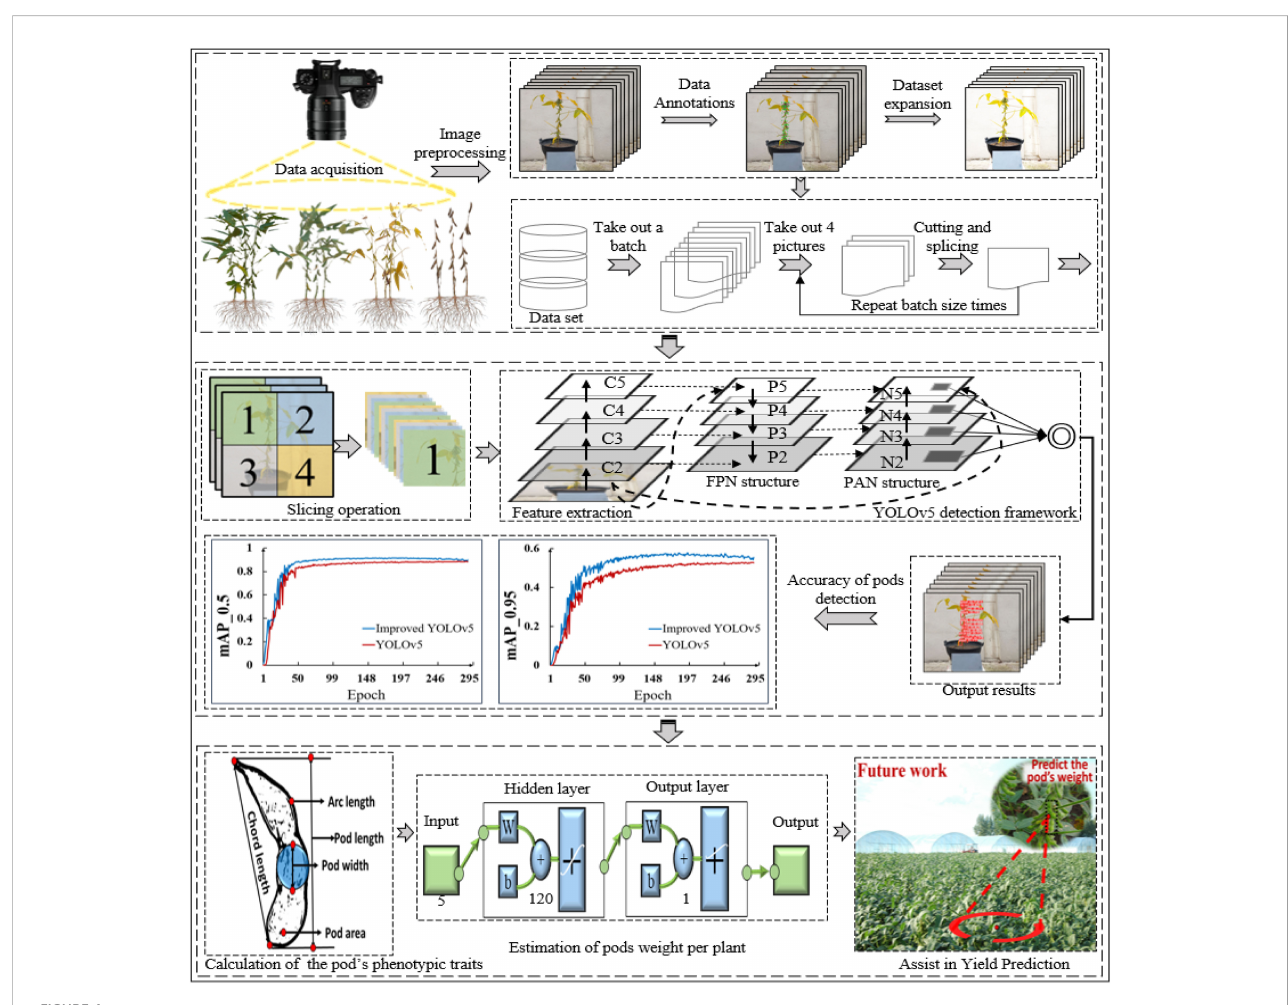
FIGURE 4 Overall framework of the soybean pod ’ s recognition and yield estimation.